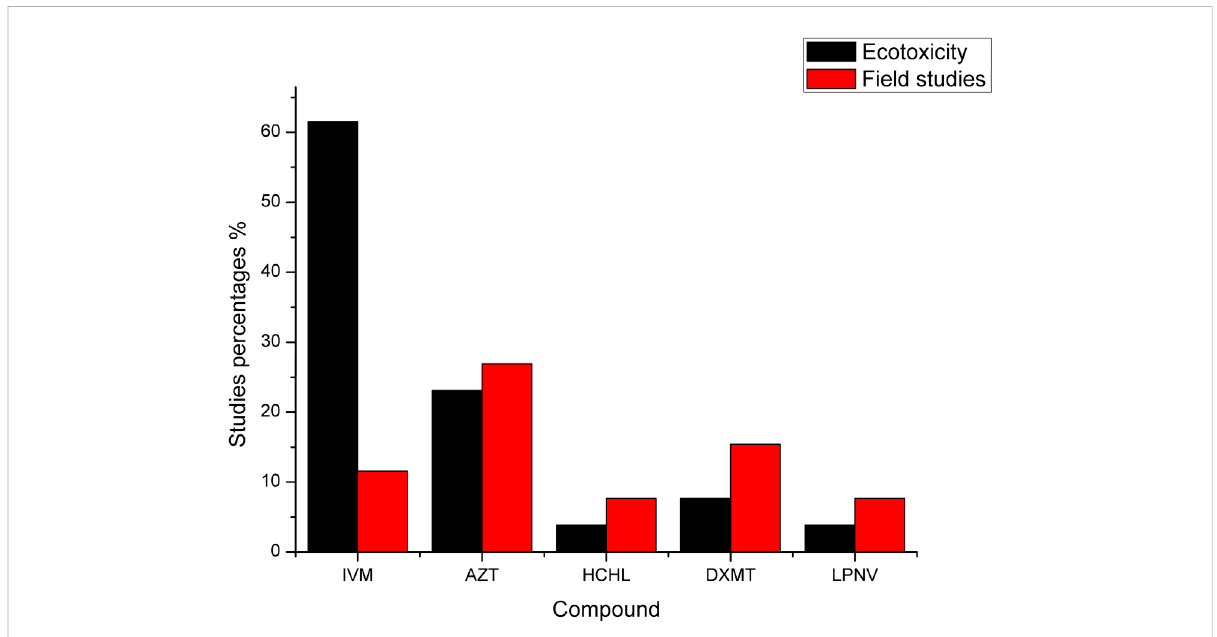
FIGURE 1 Inlaboratories, the percentage ofstudies on thepresence of ivermectin, azithromycin, hydroxyquinone, Dexamethasone and Antivirals toxicity